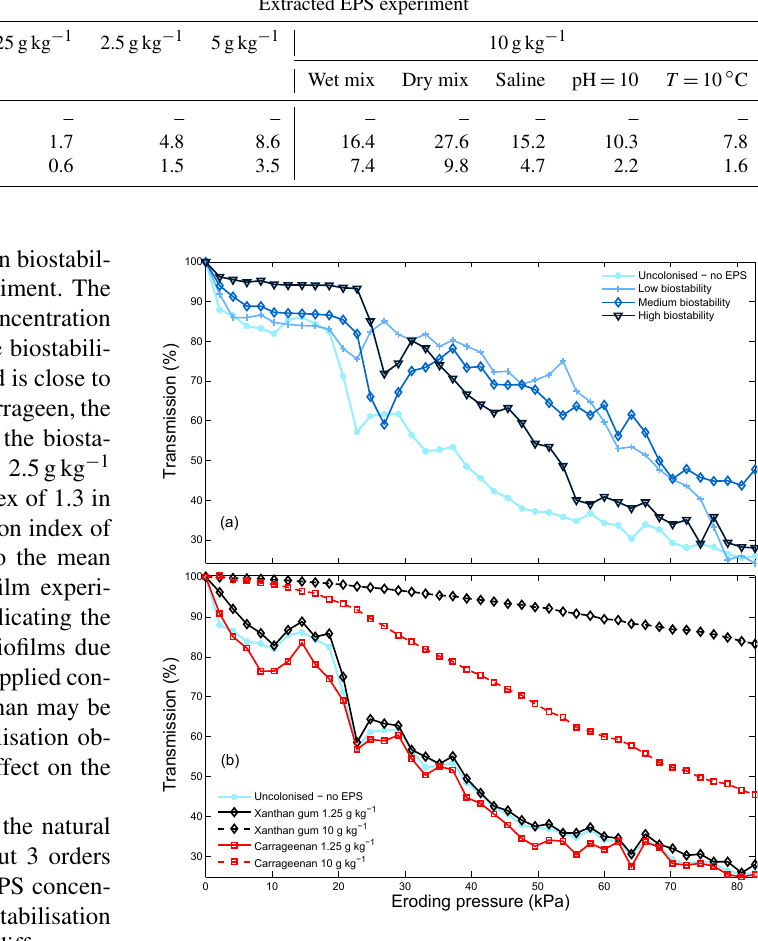
Figure 10. CSM erosion profiles for sediment with different de- grees of biostability due to natural biofilm colonisation (a) and due to different extracted EPS xanthan gum and carrageenan con- tents (b) . Following Tolhurst et al. (1999), the eroding pressure cor- responding to a 90% transmission is defined as the erosion